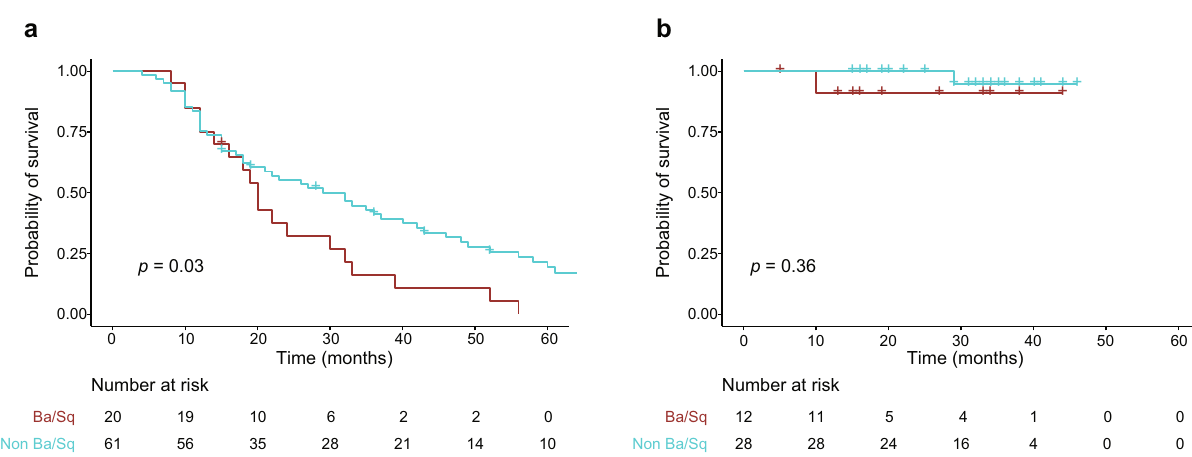
Fig. 1 Kaplan – Meier survival analysis strati fi ed by gene expression subtype. Probability of overall survival for patients treated with fi rst-line chemotherapy ( a ) or NAC ( b ) with and without Ba/Sq gene expression subtype. P values were calculated using a log-rank test for comparing survival curves. Source data are provided as a Source data fi